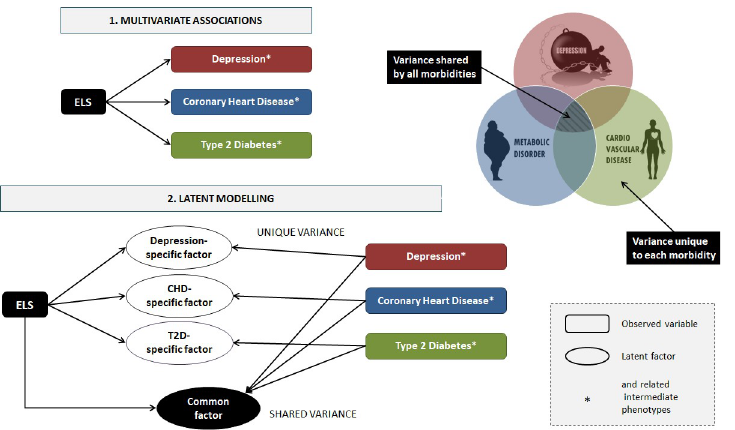
Fig 3. Differences between (1) simple multivariate analysis and (2) latent modelling of psycho-cardio-metabolic multi-morbidity implemented in EarlyCause.